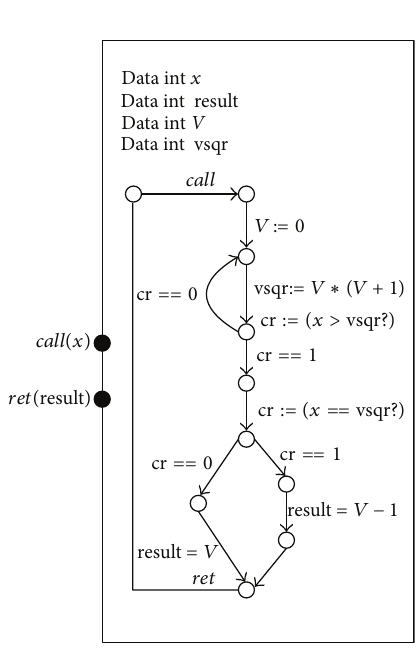
Figure 12: Program